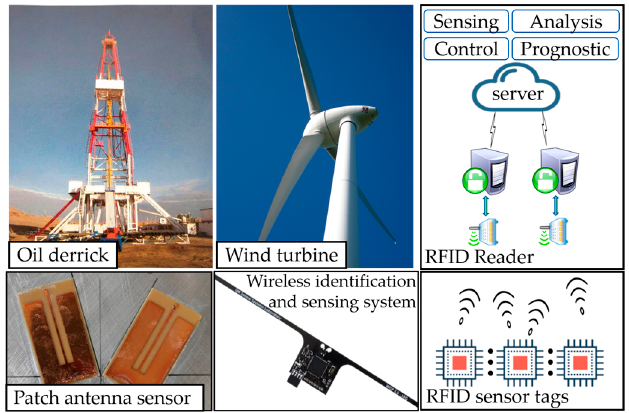
Figure 1. RFID sensor tags for SHM systems.